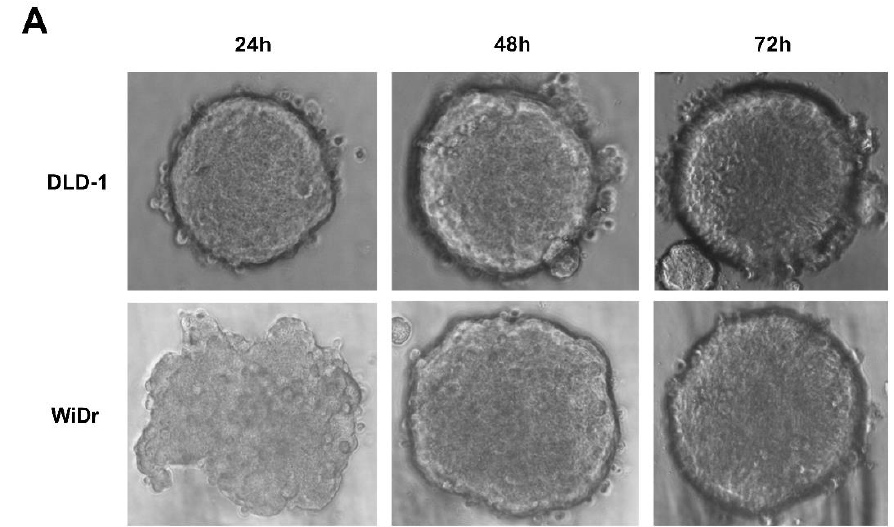
detected after incubating with rhTRAIL DHER and PCI34051.